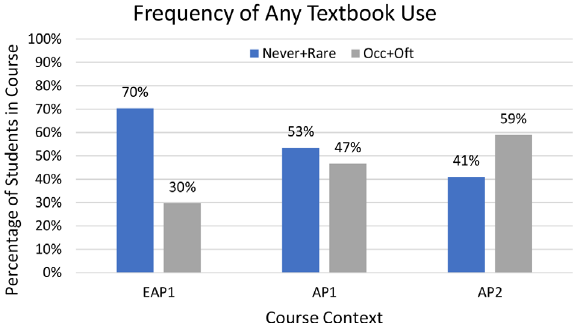
FIG. 6. Percentage of students in Extended Analytical Physics